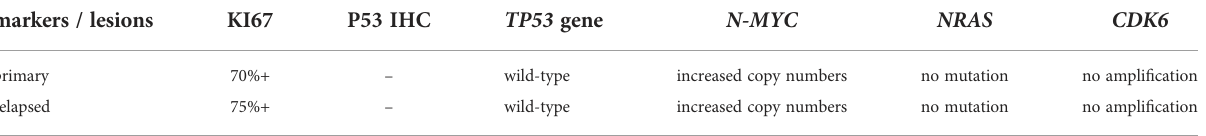
TABLE 3 Pathological and molecular features of case 8.